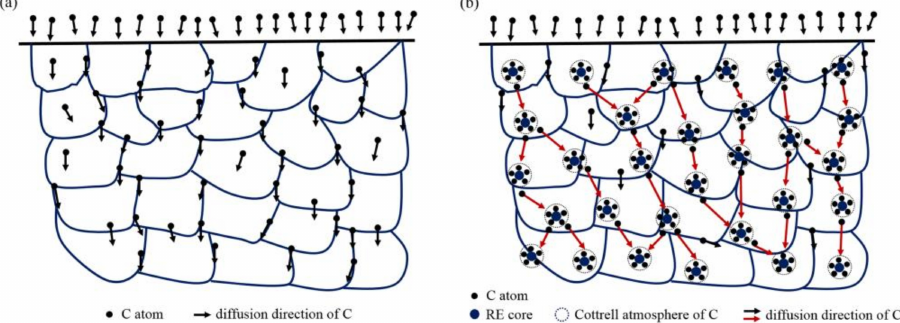
Figure 16. Di ff usion models of ( a ) conventional carburizing and the ( b ) RE carburizing